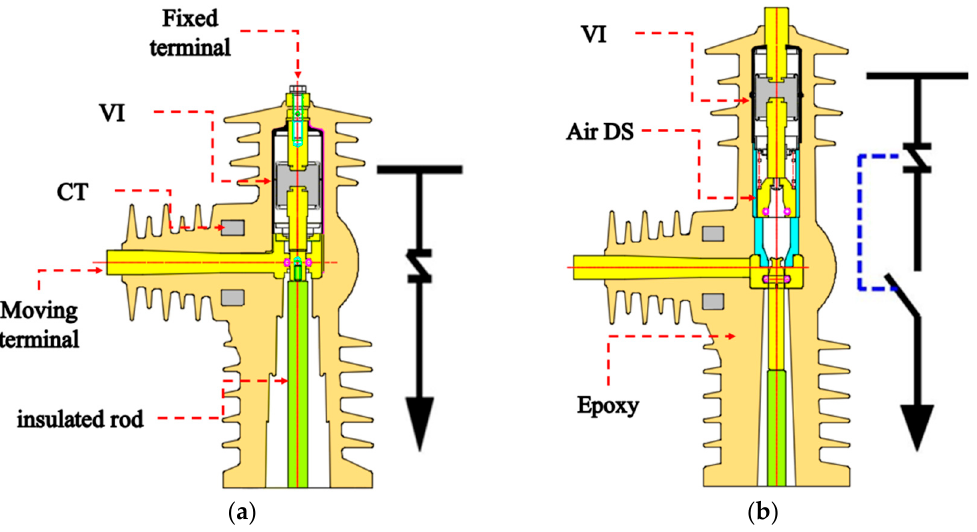
Figure 1. VI structure and VI+AIR DS structure: ( a ) conventional VI structure and ( b ) new VI+AIR DS structure.